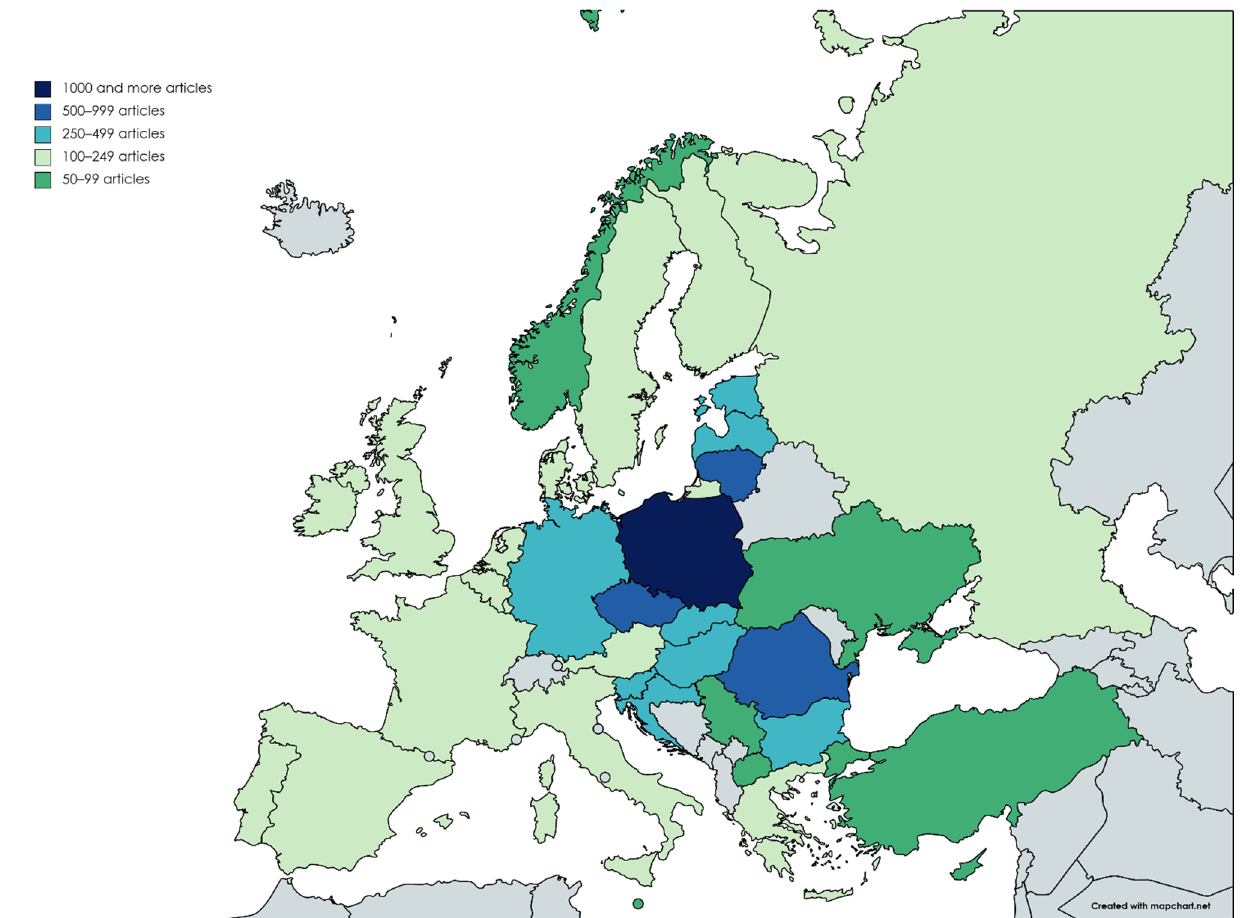
Figure 5. Number of articles (above 50) examining select countries. Source: Authors; N = 3534; made with Mapchart.net (accessed on 20 July 2022).